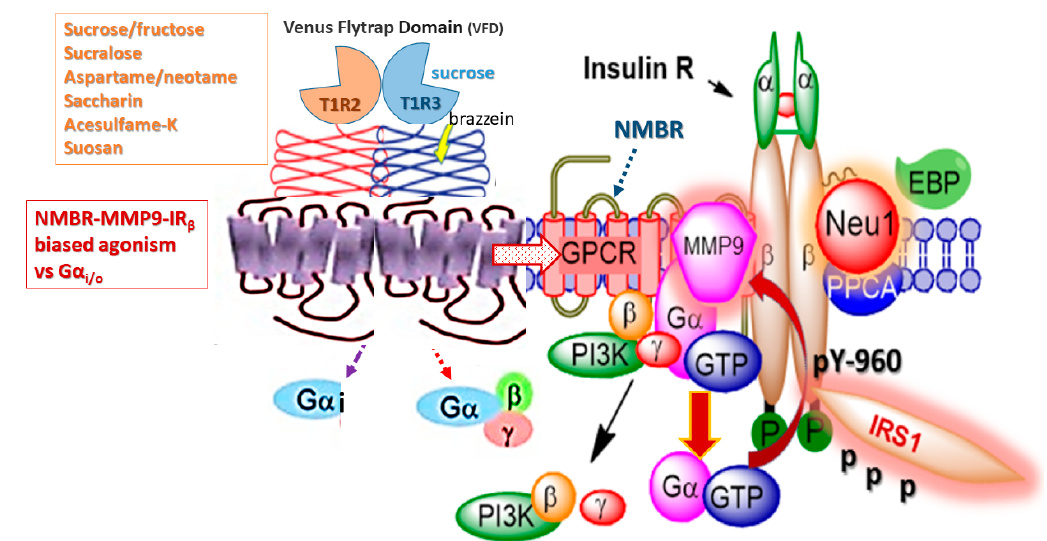
Figure 3. Hypothetical G protein-coupled receptor (GPCR) heterodimeric T1R2/T1R3 taste receptors exist in a multimeric receptor complex with NMBR, IR β , and Neu-1 in naïve IR expressing cells. Here, TIR2/TIR3 dimeric receptors are proposed to exist as a molecular link regulating the interaction and signaling mechanism(s) between these molecules on the cell surface. This molecular model uncovers a biased TIR2/TIR3 GPCR agonist-induced IR β transactivation signaling axis, mediated by Neu-1 sialidase and modification of insulin receptor glycosylation. This novel biased GPCR-signaling platform potentiates neuraminidase-1 (Neu-1) and matrix metalloproteinase-9 (MMP-9) crosstalk on the cell surface that is essential for the activation of the insulin receptor β subunit (IR β ) tyrosine kinases. Notes: Insulin-binding receptor α subunits (IR α ), as well as GPCR agonists, potentiate biased neuromedin B receptor (NMBR)-IR β signaling and MMP-9 activation to induce Neu-1 sialidase. Activated MMP-9 is proposed here to remove the elastin-binding protein (EBP) as part of the molecular multienzymatic complex that contains β -galactosidase/Neu-1 and protective protein cathepsin A (PPCA). Activated Neu-1 hydrolyzes α -2,3 sialyl residues of IR β at the ectodomain to remove steric hindrance to facilitate IR β subunits association and tyrosine kinase activation. Activated phospho-IR β subunits phosphorylate insulin receptor substrate-1 (pIRS1), which initiate intracellular insulin signaling via the Ras-MAPK and the PI3K-Akt pathway, among others. Abbreviations: PI3K, phosphatidylinositol 3-kinase; GTP, guanine triphosphate; IRS1, insulin receptor substrate-1; p, phosphorylation; Neu-1, neuraminidase-1. Taken in part from Cellular Signalling 43 (2018) 71–84. ©